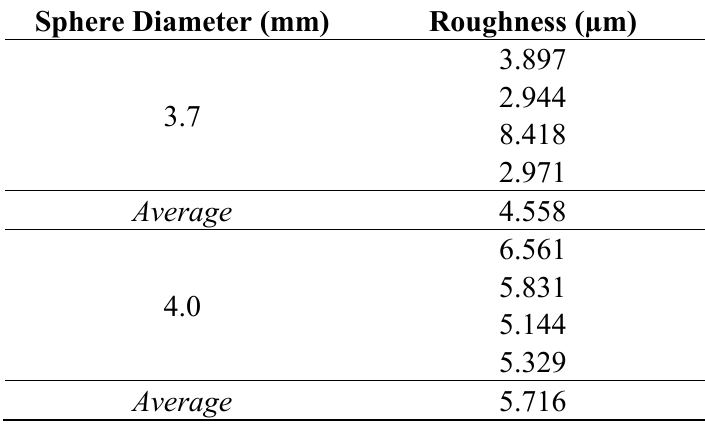
Table 2. Surface roughness measurements for 3.7 and 4.0 mm diameter hollow